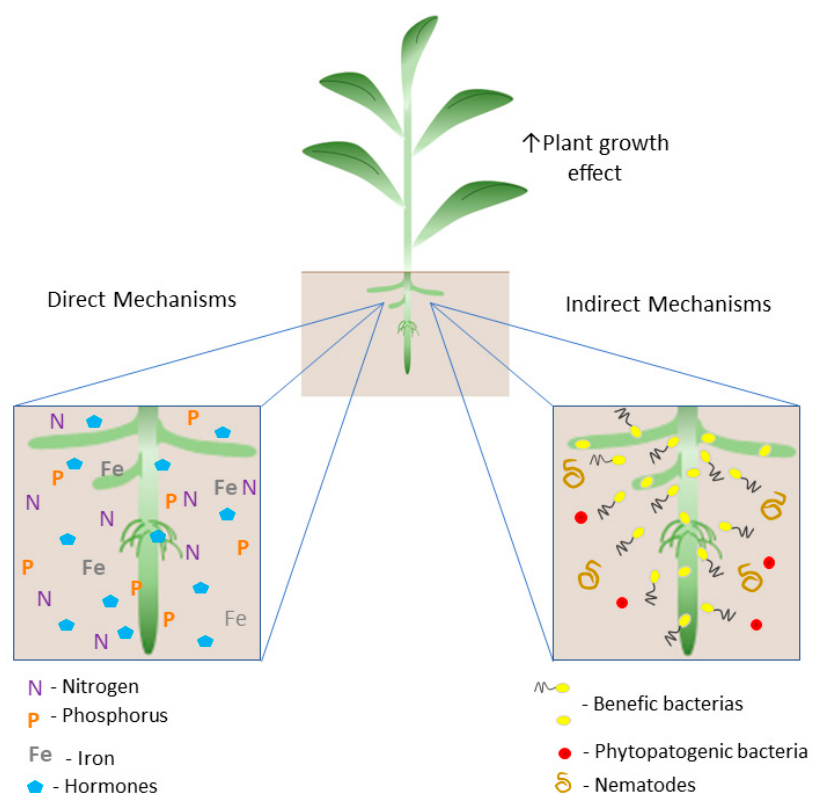
Figure 1. Schematic illustration of the plant growth promotion mechanisms by PGPB. The direct mechanism includes biological nitrogen fixation (BNF) by the activity of the nitrogenase enzyme complex; solubilization of inorganic phosphate in the soil; production of siderophores, increasing the availability of iron, and the production of hormones such as auxins, gibberellins, and cytokinin that modulate the hormonal balance of the plant host. Indirect mechanisms are related to the occupation of niches by PGPB and the production of substances with repelling functions, preventing colonization by phytopathogens and